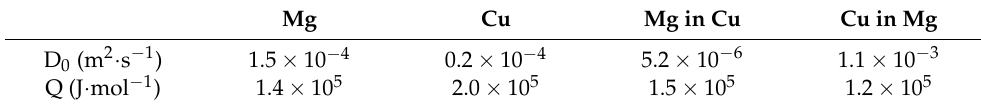
Figure 7. TEM-EDS analyses of the joint bonding at 480 ◦ C, 1500# for 30 min under 2 MPa: ( a ) HAADF- STEM image of the joint; ( b ) STEM-EDS mapping image of all elements; STEM-EDS elemental mapping images for ( c ) Cu; ( d ) Gd; ( e ) Mg; ( f ) Y; ( g ) Zn ( h ) Zr. Table 3. Proportionality constant and activation energy of Mg and